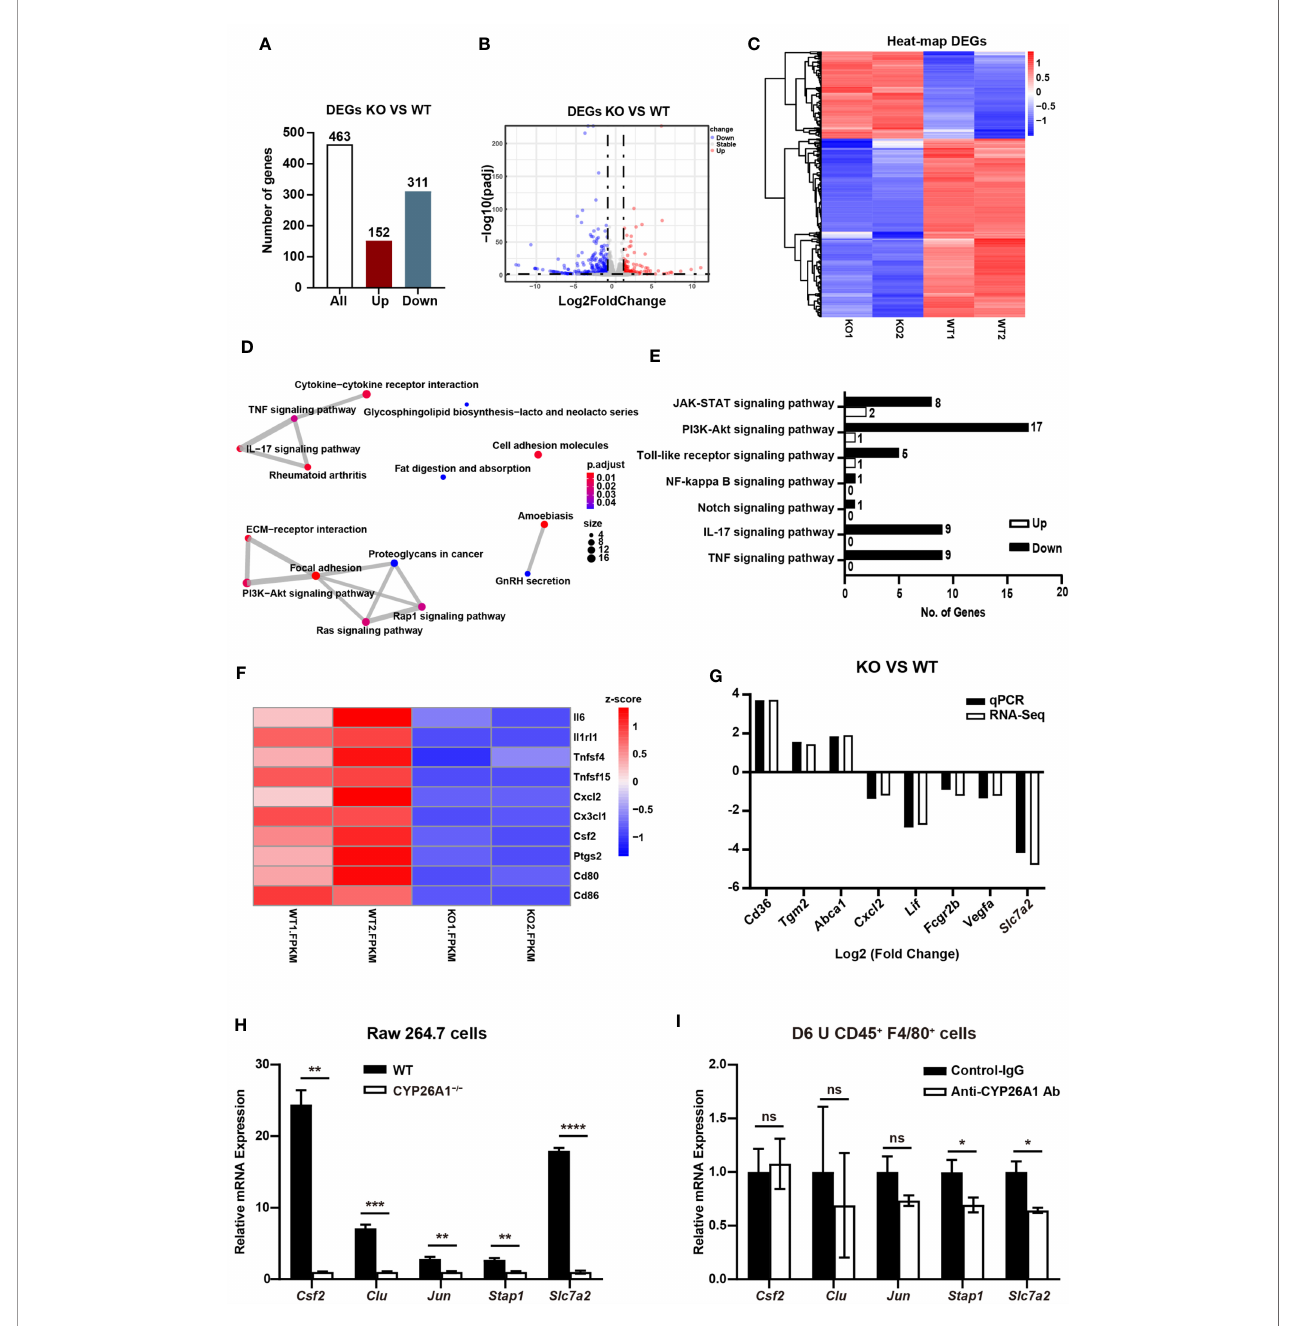
FIGURE 7 | CYP26A1 knockout changed the transcription pro fi les of Raw264.7 cells (A) The number of genes that are signi fi cantly different between the KO and WT groups. (B) Volcano plot showing up-regulated genes (red dots) and down-regulated genes (blue dots). (C) Hierarchical clustering demonstrating a distinguishable genes expression pattern between WT and KO groups. (D) Genes overlap relationship analysis on the top 15 pathways enriched by KEGG (E) KEGG analysis of the in fl ammatory related pathway. (F) Z-scores of genes associated with in fl ammation in DGEs. (G) Comparison of validated qPCR assays with RNA-Seq for selected DEGs. (H) qPCR analysis of Csf2 , Clu , Jun , Stap1 and Slc7a2 in CYP26A1-de fi cient Raw264.7 and WT cells after induced 4 h by LPS and IFN- g (n=3). (I) qPCR analysis of Csf2 , Clu , Jun , Stap1 and Slc7a2 in primary uterine macrophages treated with anti-CYP26A1 Ab or Control-IgG for 12 h and then induced with LPS and IFN- g for 4 h (n=3). Error bars represent means ± SEM; two-tailed unpaired t-test, ns, not signi fi cant, *P < 0.05, **P < 0.01, ***P < 0.001 or ****P <